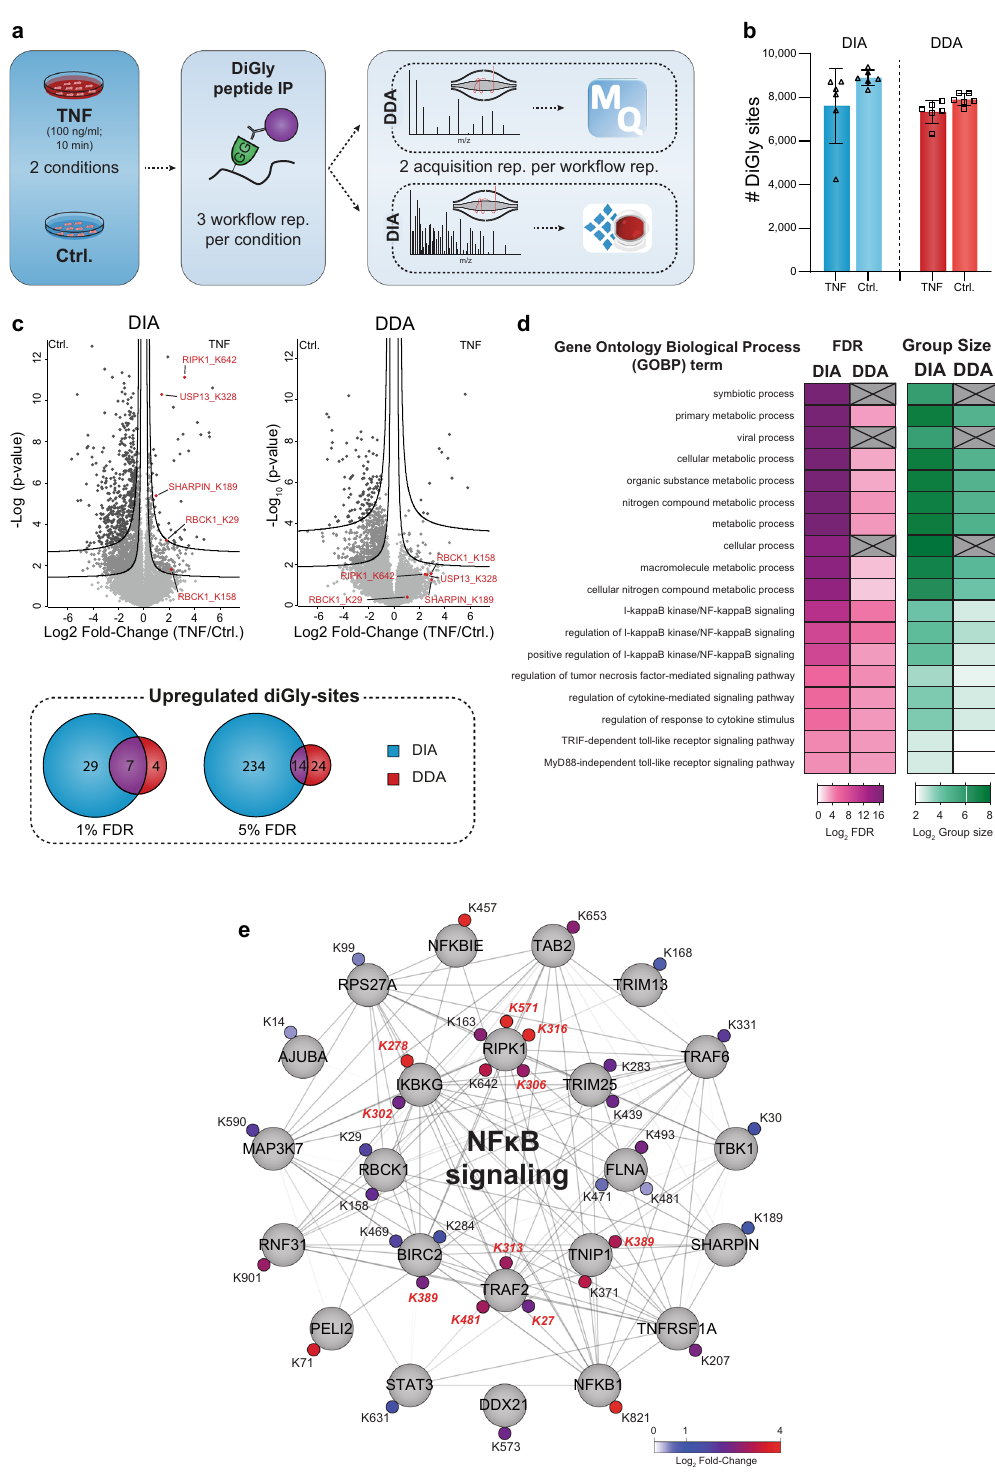
Fig. 3 DIA enables a detailed view of the TNF-regulated ubiquitinome. a Work fl ow for ubiquitinome analysis in tumor necrosis factor (TNF) signaling. b Identi fi ed diGly sites (±SD) for TNF treated (100 ng/ml for 10 min) and control U2OS cells in data-independent acquisition (DIA, blue) and data- dependent acquisition (DDA, red) experiments ( n = 6, three work fl ow replicates measured in analytical duplicates). c Volcano plot of signi fi cantly regulated diGly sites at 5% false discovery rate (FDR) (FDR controlled, two-sided t -test, randomizations = 250, s0 = 0.1) (lower line) and 1% (upper line) for DIA (blue) and DDA (red) and overlaps of signi fi cantly upregulated diGly sites for 1 and 5% FDR cutoffs ( t -test, s0 = 0.1). d Overrepresentation analysis of gene ontology biological process (GOBP) terms fi ltered for 5% corrected FDR (Fisher ’ s Exact test). e Cytoscape network of proteins with signi fi cantly upregulated diGly sites in DIA that are associated with NF κ B signaling (GO 0043122; GO 0051092; 5% FDR). Upregulated diGly sites also captured by DDA are marked in red (5% FDR). Source data are provided as a Source data fi